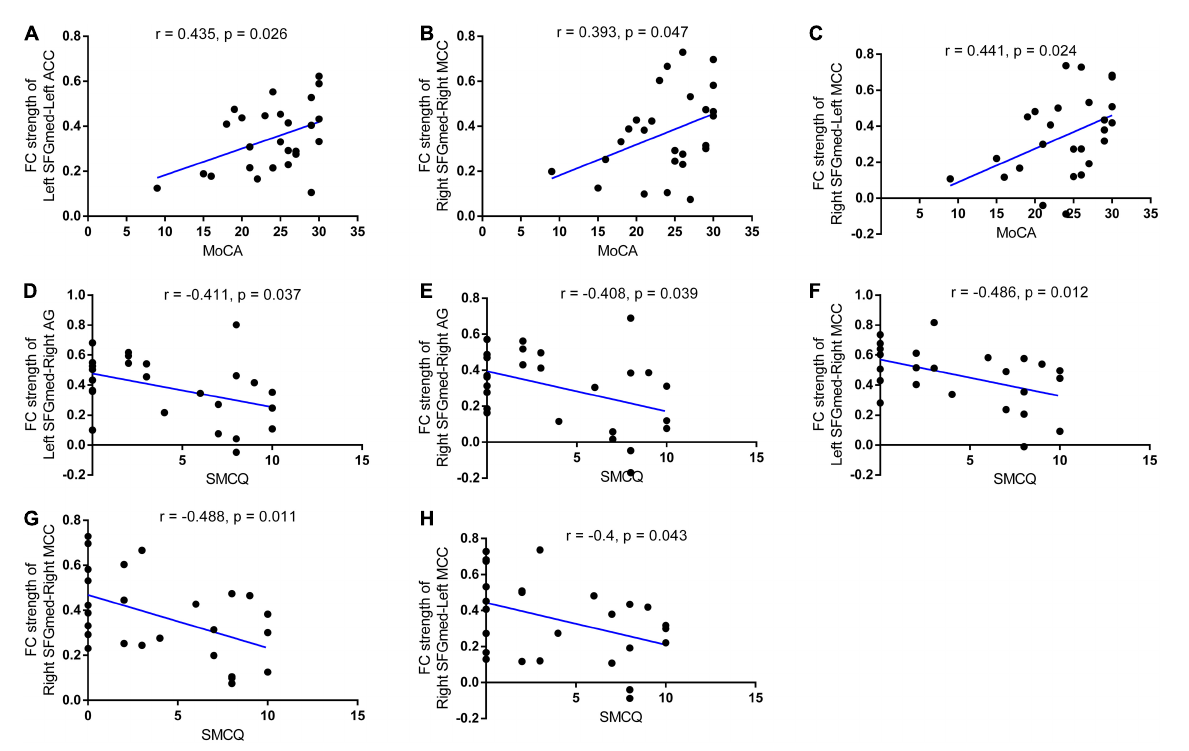
FIGURE3 Correlations between functional connectivity strength and cognitive performance in patients with ruptured ACoA aneurysm. Positive correlations between the MoCA scores and left SFGmed-left ACC (A) , right SFGmed-right MCC (B) , as well as right SFGmed-left MCC (C) connectivity strength were discovered in patients with ruptured ACoA aneurysm. Negative correlations between the SMCQ scores and left SFGmed-right AG (D) , right SFGmed-right AG (E) , left SFGmed-right MCC (F) , right SFGmed-right MCC (G) , and right SFGmed-left MCC (H) connectivity strength were displayed in patients with ruptured ACoA aneurysm. ACoA, anterior communicating artery; SFGmed, medial superior frontal gyrus; AG, angular gyrus; MoCA, Montreal Cognitive Assessment; ACC, anterior cingulate cortex; MCC, middle cingulate cortex; SMCQ, Subjective Memory Complaints